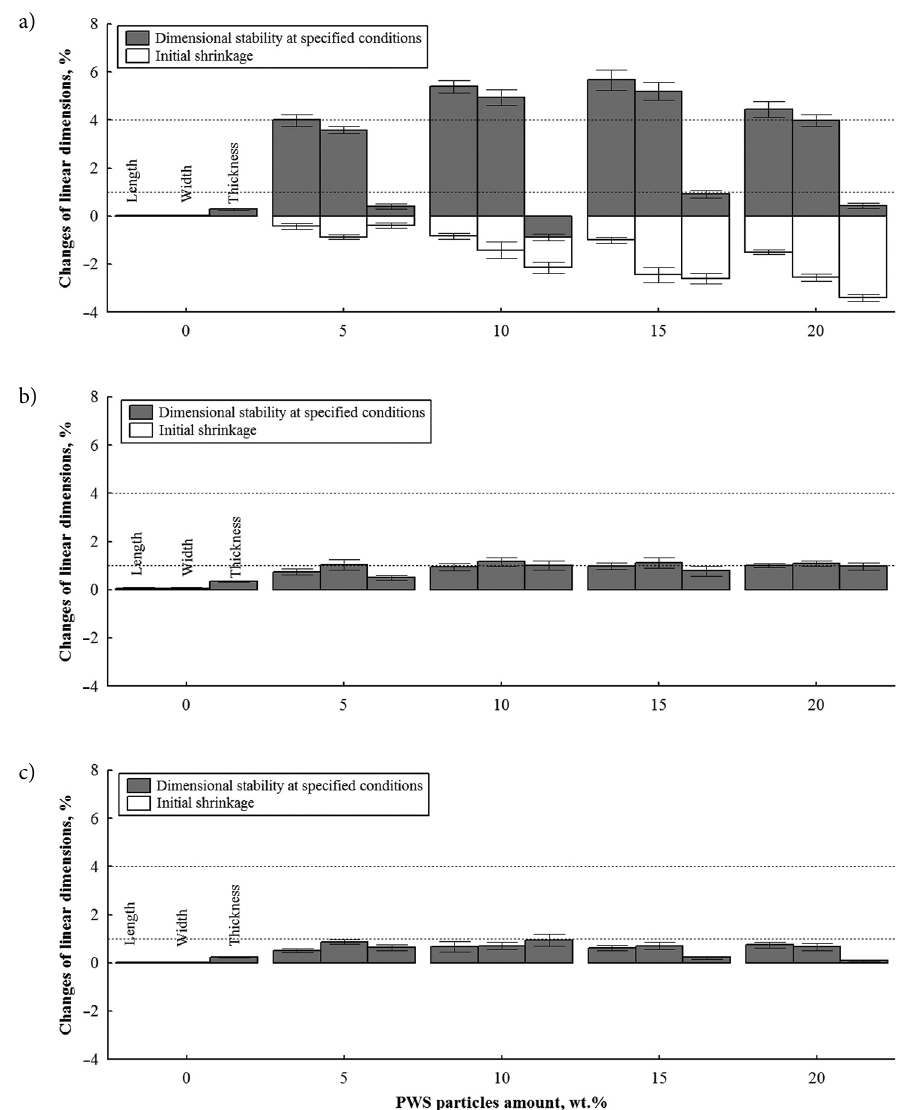
Fig. 5. Shrinkage and dimensional stability of PWS filled polyurethane foam composites modified with a) 10 pbw; b) 15 pbw and c) 20 pbw of RPG. (------) – minimum allowable changes in dimensions in the directions of length, width and thickness according to EN 13165:2012+A2:2016 Table 6. Closed cell content of RPG extended and PWS filled polyurethane foam composites Amount of PWS, wt.% Amount of Parameter RPG, pbw 0 Closed cell content, vol. %